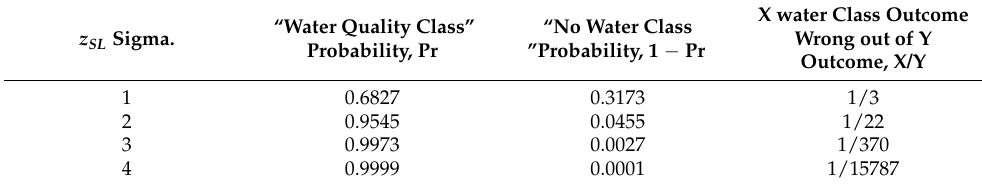
Table 6. Water quality class probability regarding sigma level.